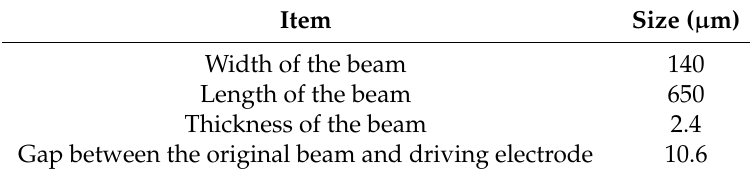
Table 3. Geometric parameters of the actual machining switch.